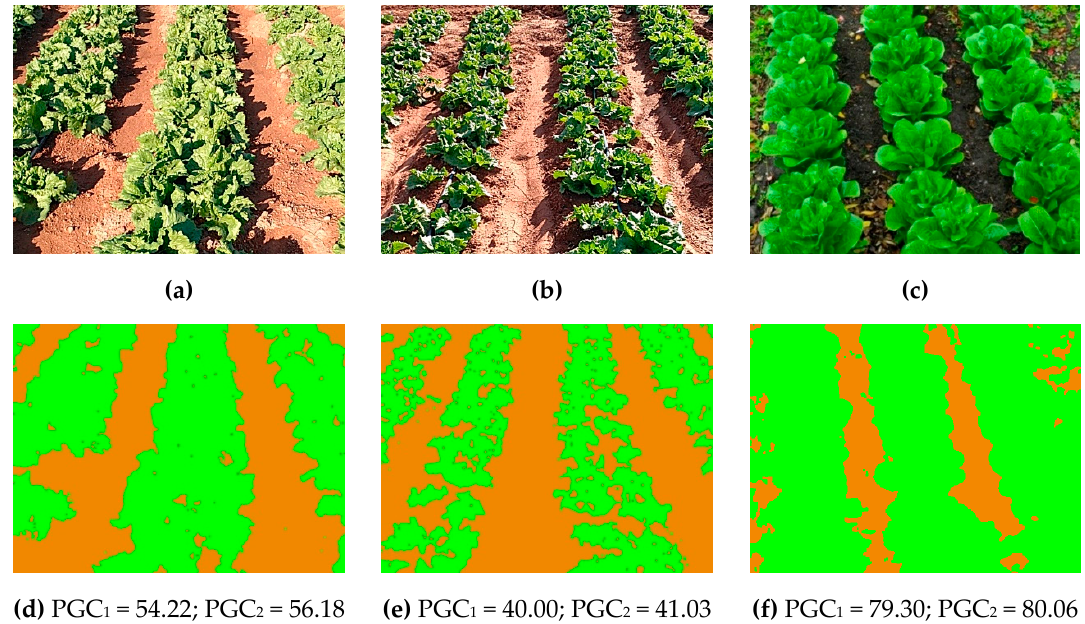
Figure 15. Plant/soil segmentation of the images obtained by the RICS nodes for a crop of lettuce. ( a ), ( b ) and ( c ) are captured images. ( d ), ( e ) and ( f ) are segmented images. For each image, the percentage of green cover is indicated using the L*a*b* (PGC 1 ) and I1I2I3 color model (PGC 2 ). PGC = the percentage of green cover.